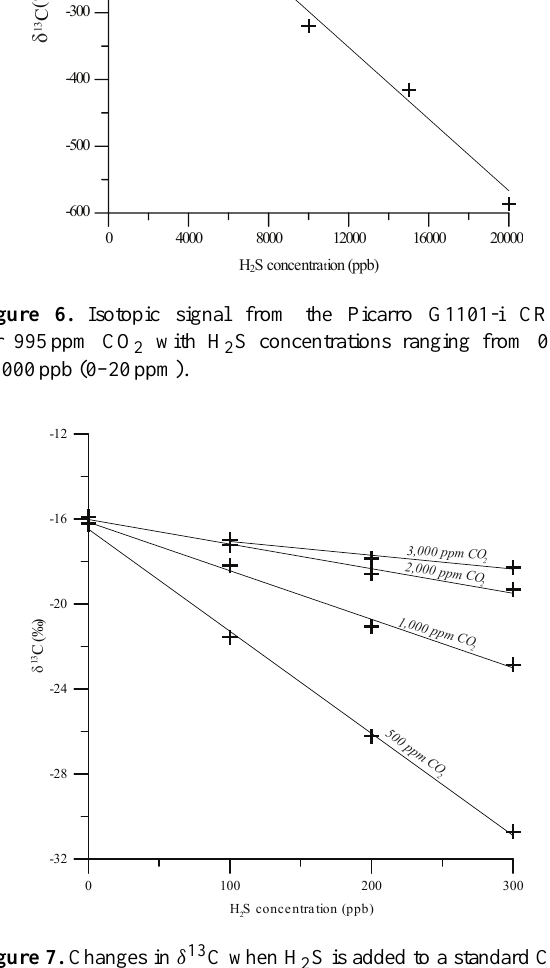
Figure 7. Changes in δ 13 C when H 2 S is added to a standard CO 2 gas ( − 16.0‰) at varying CO 2 concentrations. The H 2 S interfer- ence is strongly dependent on the CO 2 concentration of the